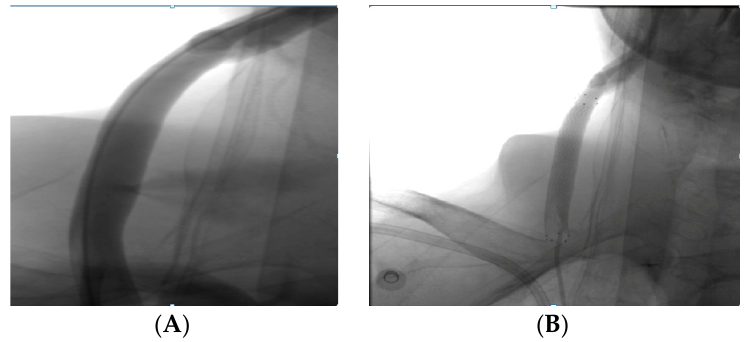
Figure A2. Intra-operative ( A ) and post-operative ( B ) angiogram.